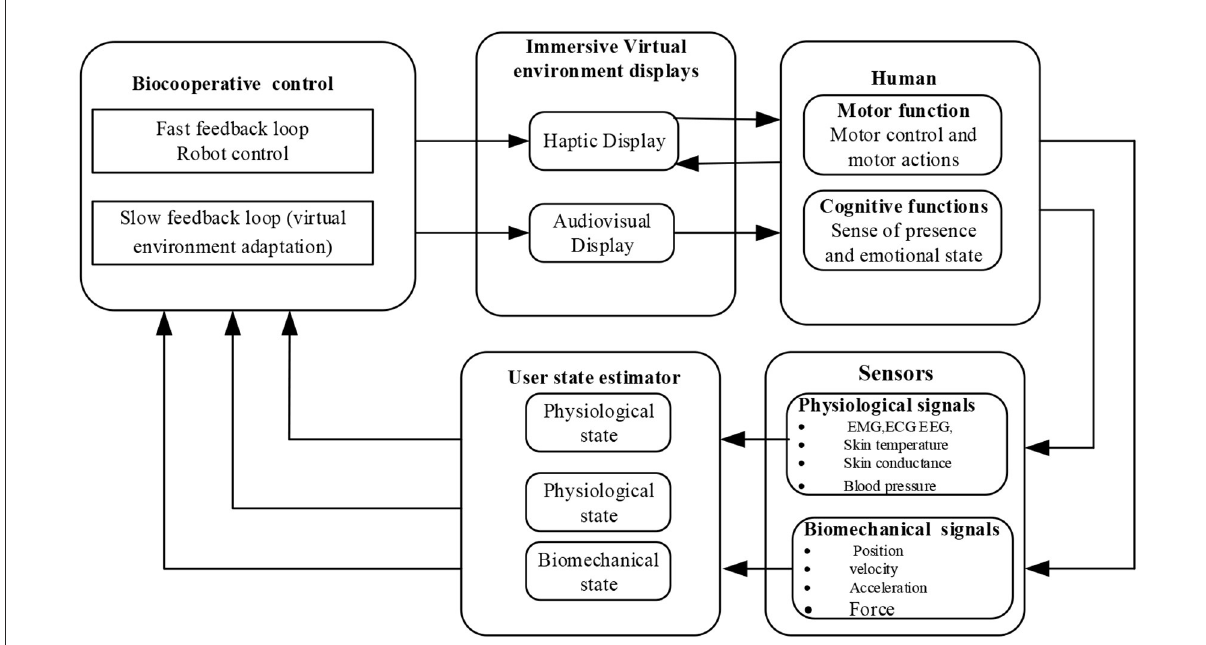
FIGURE6 A human-robot bio-cooperative control system. Humans are in the loop regarding biomechanical, physiological, and psychological aspects (Riener and Munih, 2010).